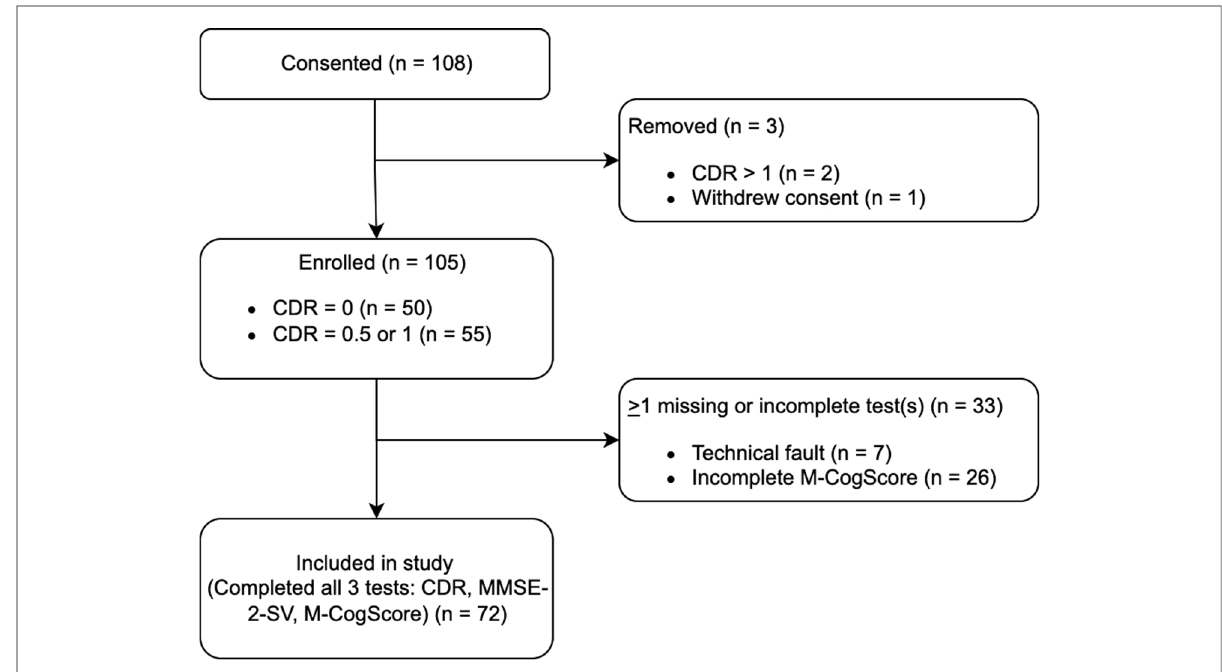
FIGURE 1 Participant fl ow diagram. There were 26 incomplete data for M-CogScore. Additionally, 7 participants ’ M-CogScore data failed to upload to Amazon Web Services Cloud due to issues with internet